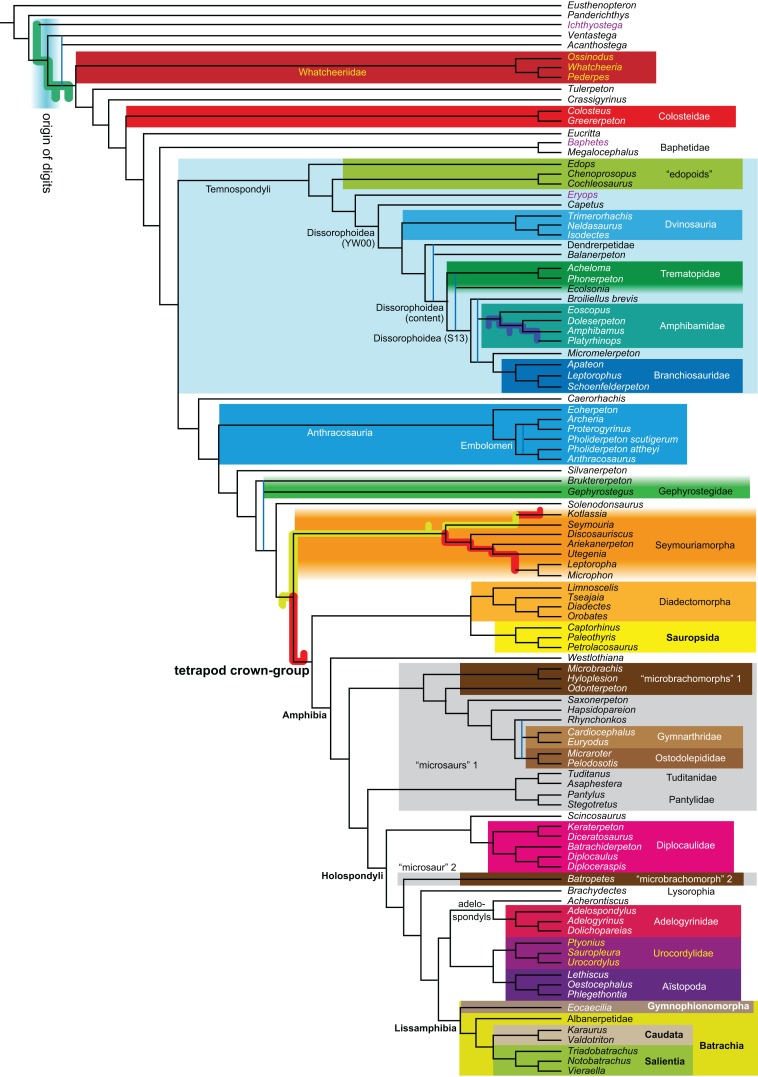
Representation of those MPTs from Analysis R1 where Anthracosauria lies crownward of Temnospondyli.See legend of Fig. 10 for more information. Note the additional position of Ichthyostega (immediately crownward of Ventastega and rootward of Acanthostega) and the fixed position of Caerorhachis (outside of Temnospondyli, though close to it). Purple underlay: Platyrhinops (three positions); yellow: Kotlassia (three positions); red: (Leptoropha + Microphon) (three positions).